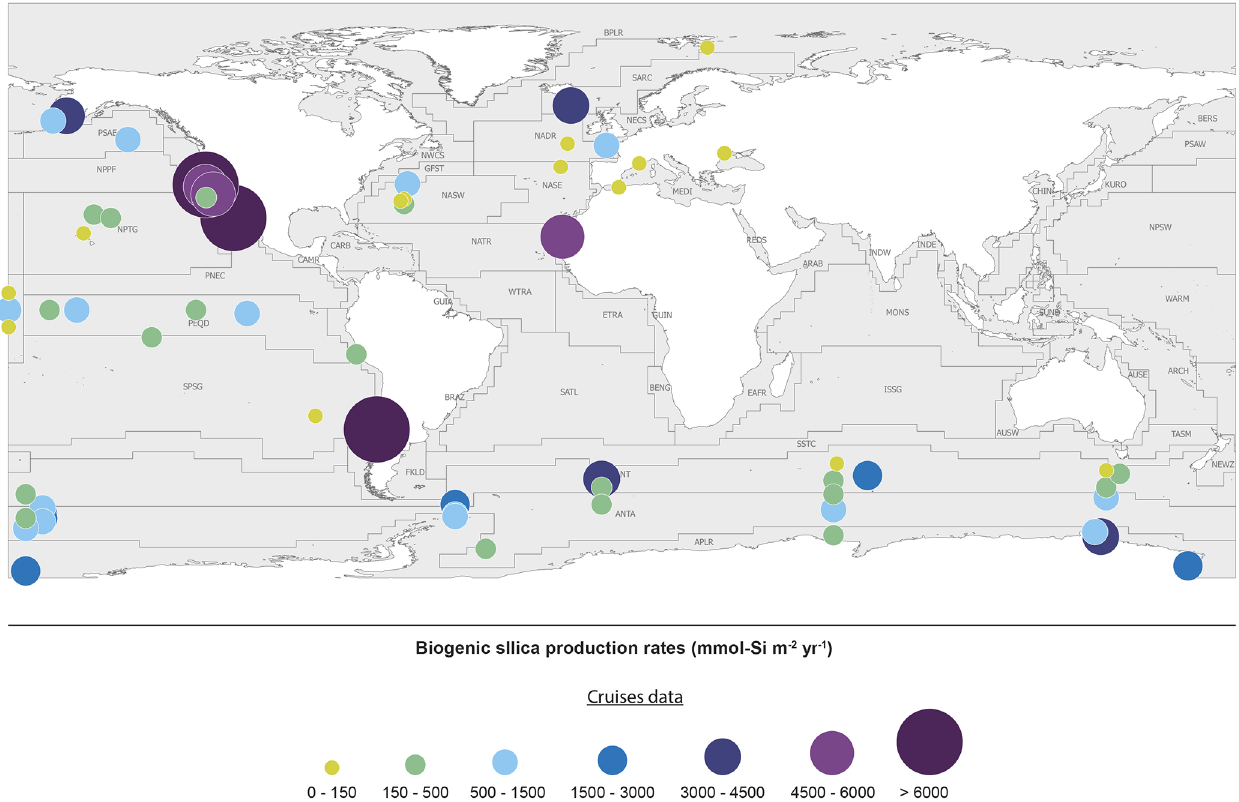
Figure 3. Biogenic silica production measurements in the world ocean. Distribution of stations in the Longhurst biogeochemical provinces (Longhurst, 2007; Longhurst et al., 1995). All data are shown in Sect. S4 in the Supplement (Annex